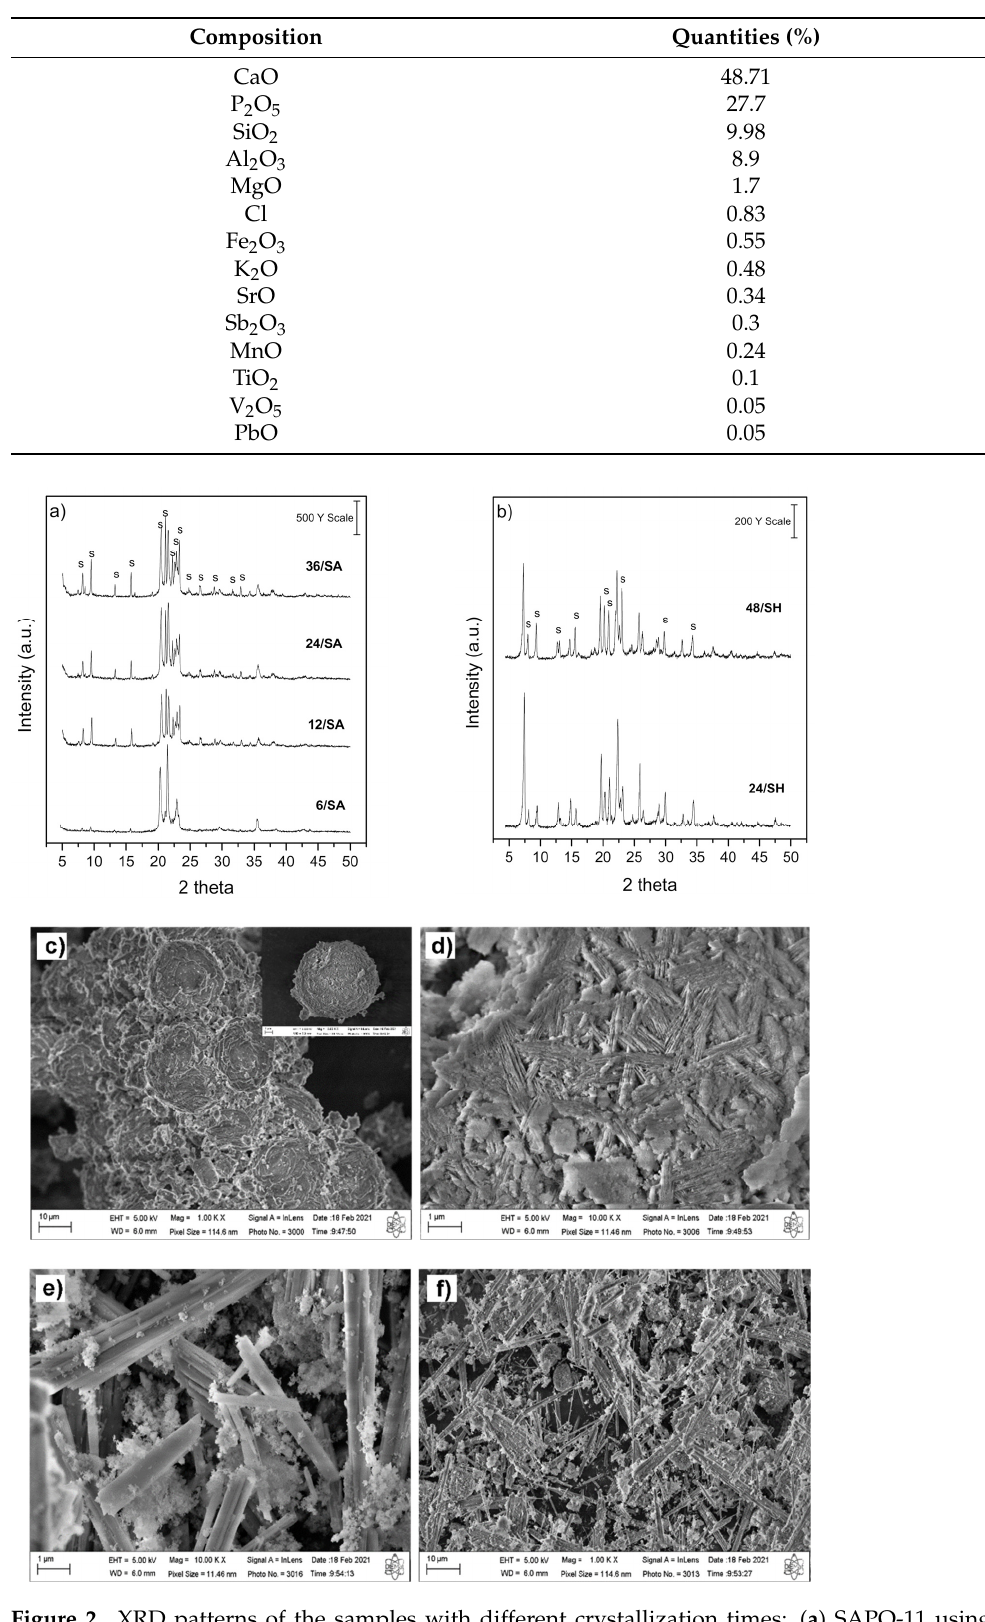
Table 2. Chemical composition from the residue of the fluorescent lamp.